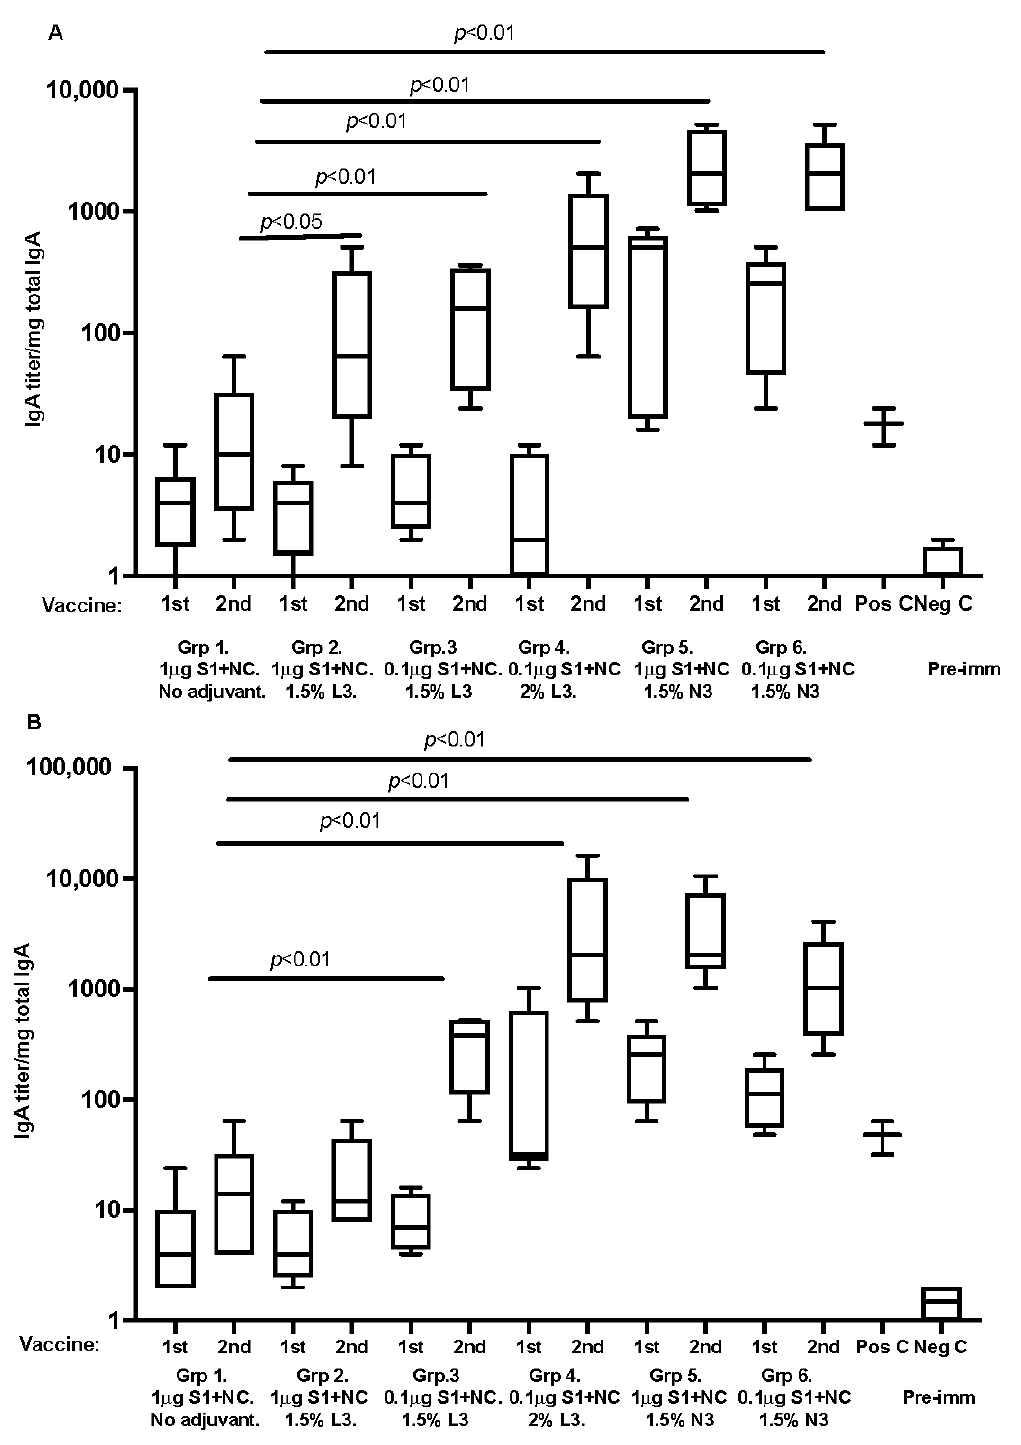
Figure 3. ( A ) and ( B ) graphs are representing respiratory tract lung ‐ washed IgA antibody analyzed against S1 spike protein and ( B ) fecal pellet extracted IgA against S1 spike protein, respectively. Data are driven from 5 individuals per group, p value < 0.05.